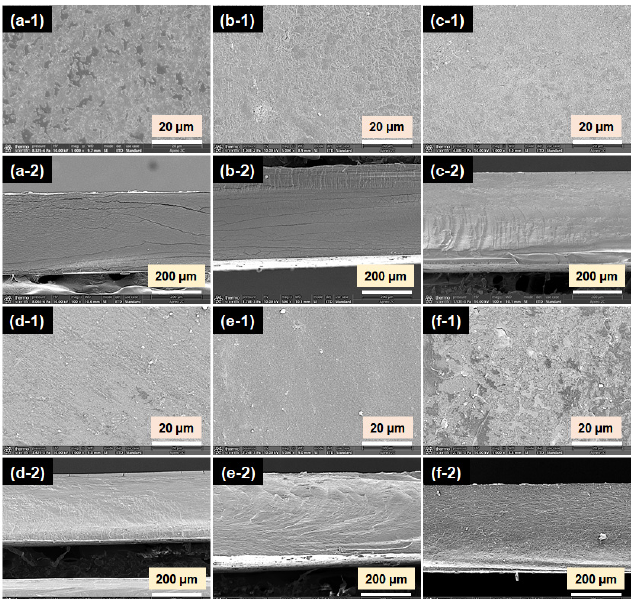
Figure 3. SEM micrographs of surfaces ( 1 ) and cross-sections ( 2 ) of GBFs: GF ( a ); GGF ( b ); GGCF-1 ( c ); GGCF-2 ( d ); GGCF-3 ( e ); GGCF-4 ( f ).